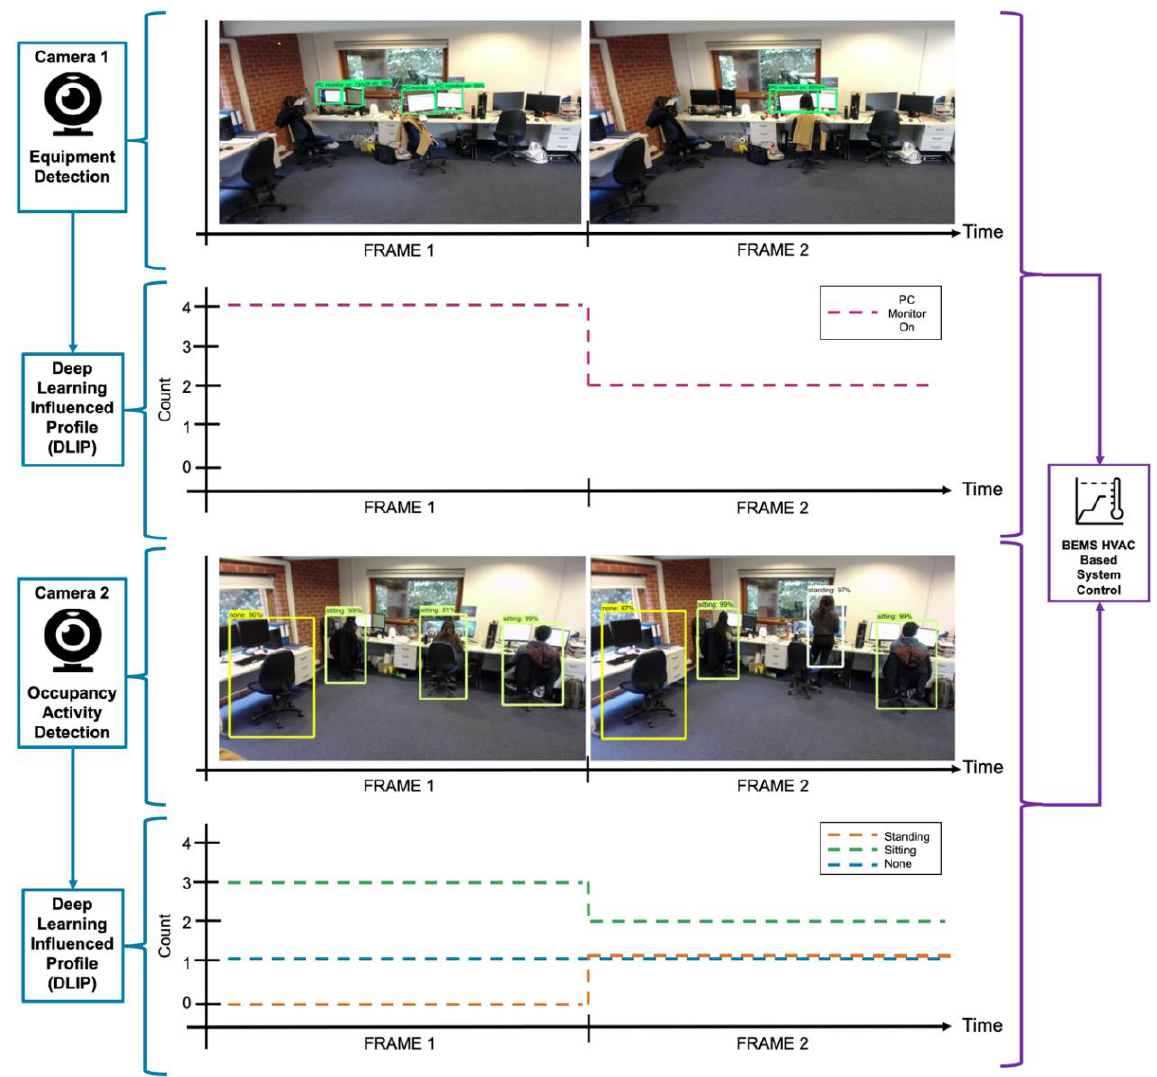
Figure 6. Process of forming the DLIP for (1) equipment, and (2) occupancy activity detection and recognition.